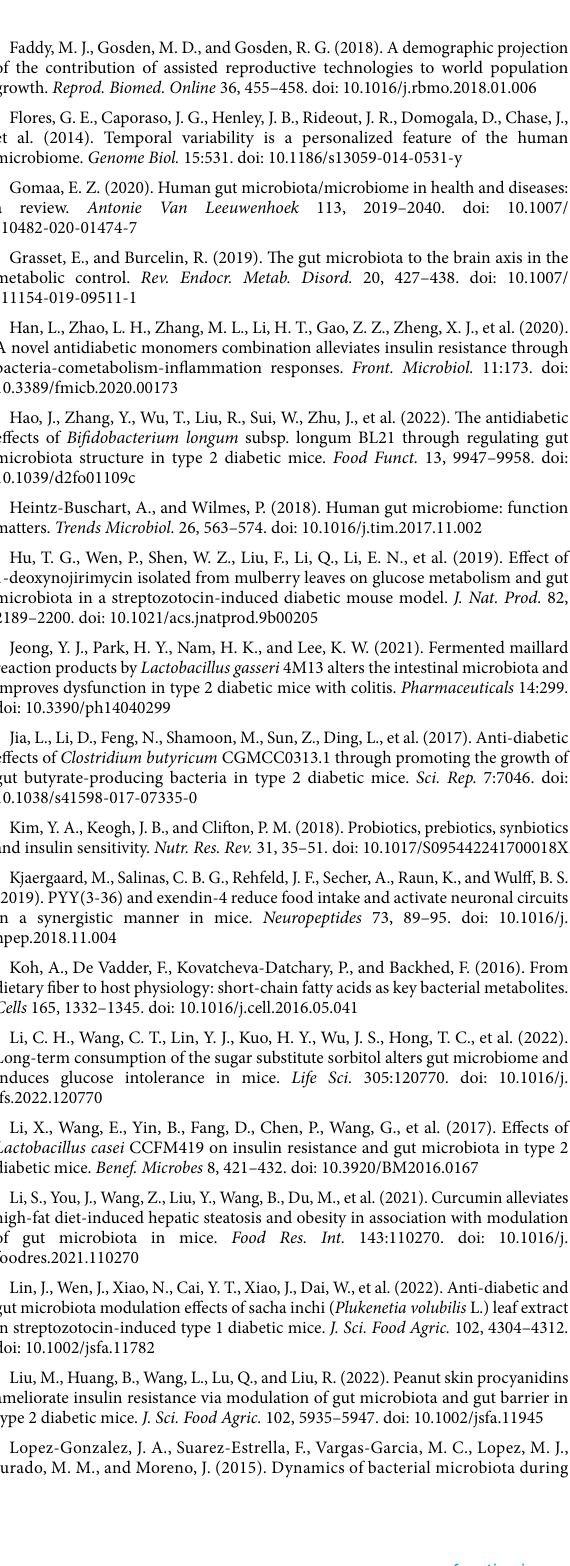
SUPPLEMENTARY FIGURE S2 Serum SCFA concentration in 24-week-old NC-NC, HE-HE, and NC-HE mice. Error bars represent SEM. Significance determined by one-way ANOVA. ** p < 0.01; *** p < 0.001; **** p < 0.0001; ns, not